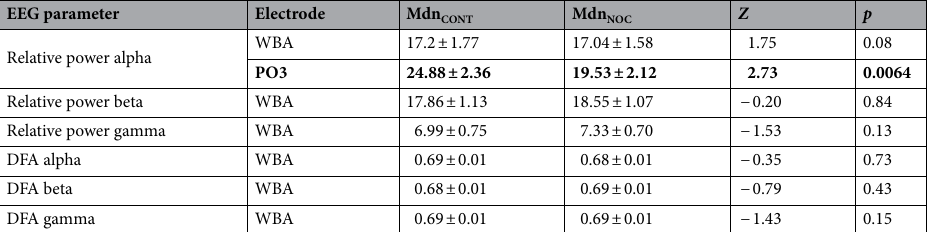
(Fig. 3e–h). We then asked whether neurophysiological changes in spectral power were also observed during the evocation phase of the study. No significant differences were observed between nocebo and control trials in the evocation phase (supplementary material).